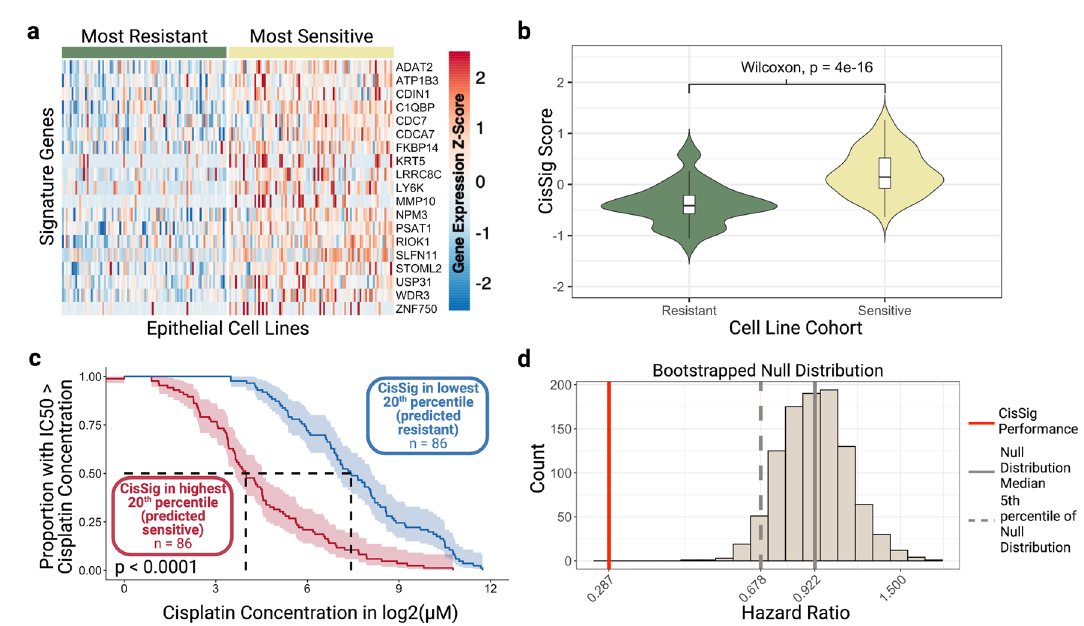
Fig. 3 Visualization of CisSig expression within GDSC dataset. a An unclustered heatmap showing gene expression of the CisSig genes (rows) in cell lines (columns) from the top and bottom quintiles of cisplatin IC50. Color of the heatmap represents the Z-score of gene expression, normalized to each gene. Cell lines denoted as sensitive (right, yellow bar) tend to display higher expression of CisSig genes than cell lines denoted as resistant (left, green bar). Z-scores above 2.5 are denoted as 2.5, and Z-scores below − 2.5 are denoted as − 2.5. b Violin plots comparing the distribution of CisSig scores between the cell lines in the highest and lowest quintile of cisplatin IC50. A Wilcoxon rank- sum test found that the median CisSig scores between these two cohorts was signi fi cantly different ( p < 0.0001). c Comparison of the distribution of cisplatin IC50 between cell lines in the highest and lowest quintile of CisSig score. Y-axis represents the proportion of the cohort with a cisplatin IC50 greater than the cisplatin concentration on the X-axis. A log-rank test between the two cohorts demonstrates signi fi cantly different drug response between the two cohorts ( p < 0.0001). d Null distribution of hazard ratio using 1000 random gene signatures with the same length as CisSig and the model described in ( c ). CisSig ’ s performance is compared to the 95% con fi dence interval of the null distribution, where each signature ’ s performance (CisSig and nulls) is represented by the hazard ratio between two cohorts separated by the signature score. Created with BioRender.com.